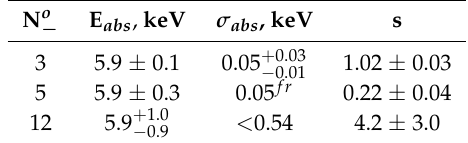
Table A6. Parameters of the absorption lines (if